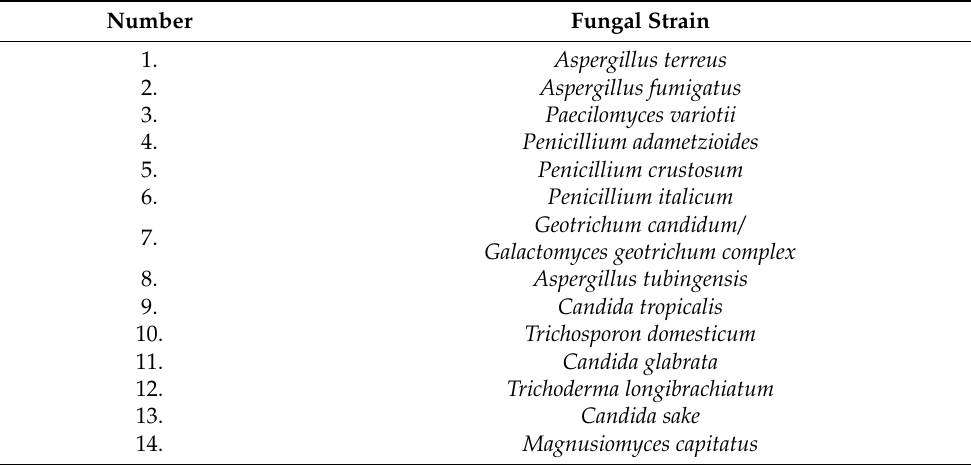
Table 1. Fungal isolates from the activated sludge were identified by sequence comparison with GenBank [37] .